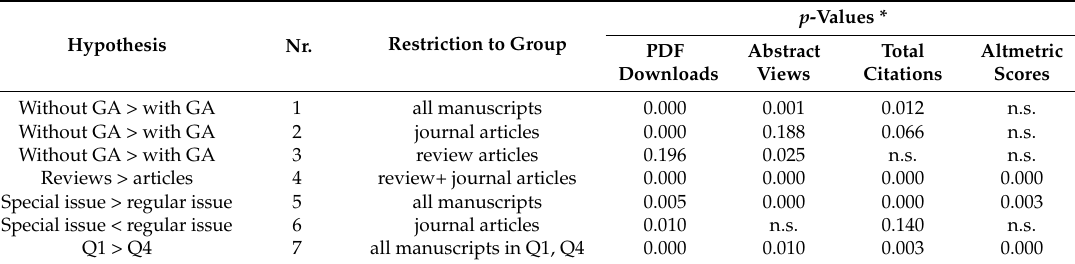
Table 3. Summary of inductive statistics. * p > 0.2 not significant